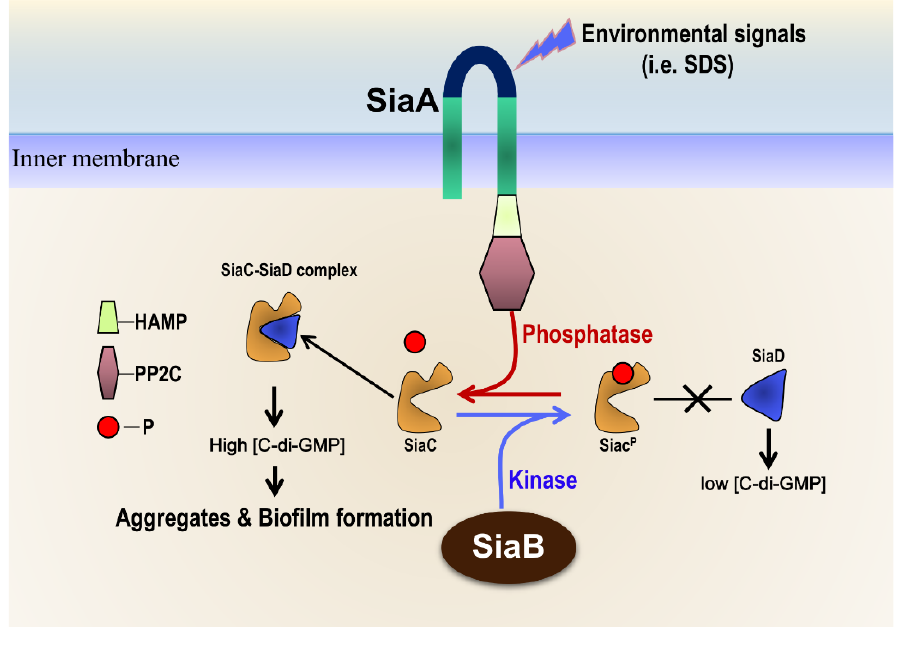
FIGURE 1: Proposed model